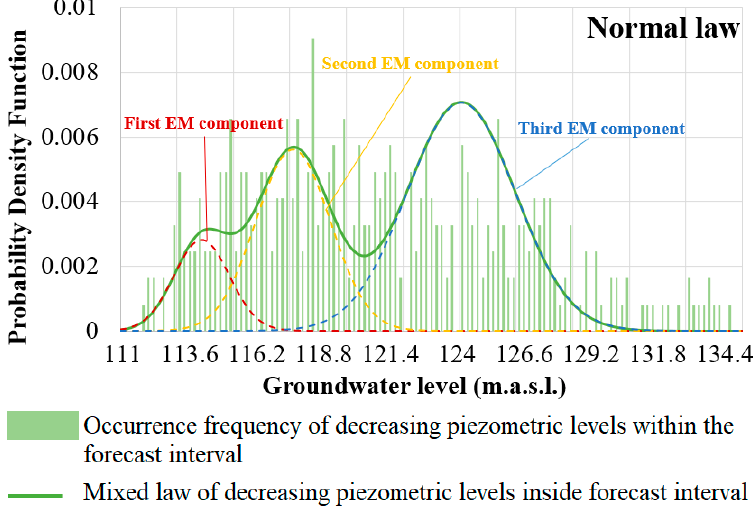
Figure 7. Theoretical composite pdf of piezometric levels, obtained using Esperance Maximization (EM) algorithm using a Normal law and applied to observed values having a decreasing slope and being inside the prediction interval. Each elementary normal law is represented with a different color and denoted as ”EM component.”